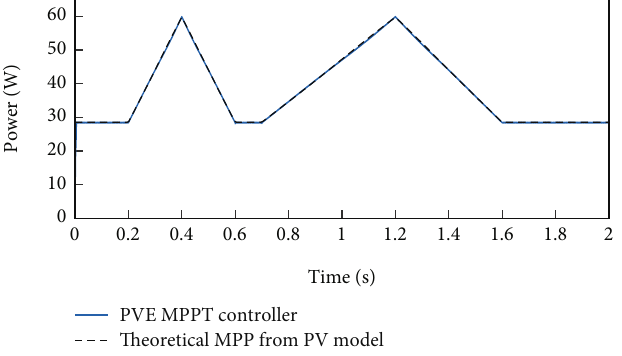
Figure 29: Power of the PVE system with MPPT control under the EN 50530